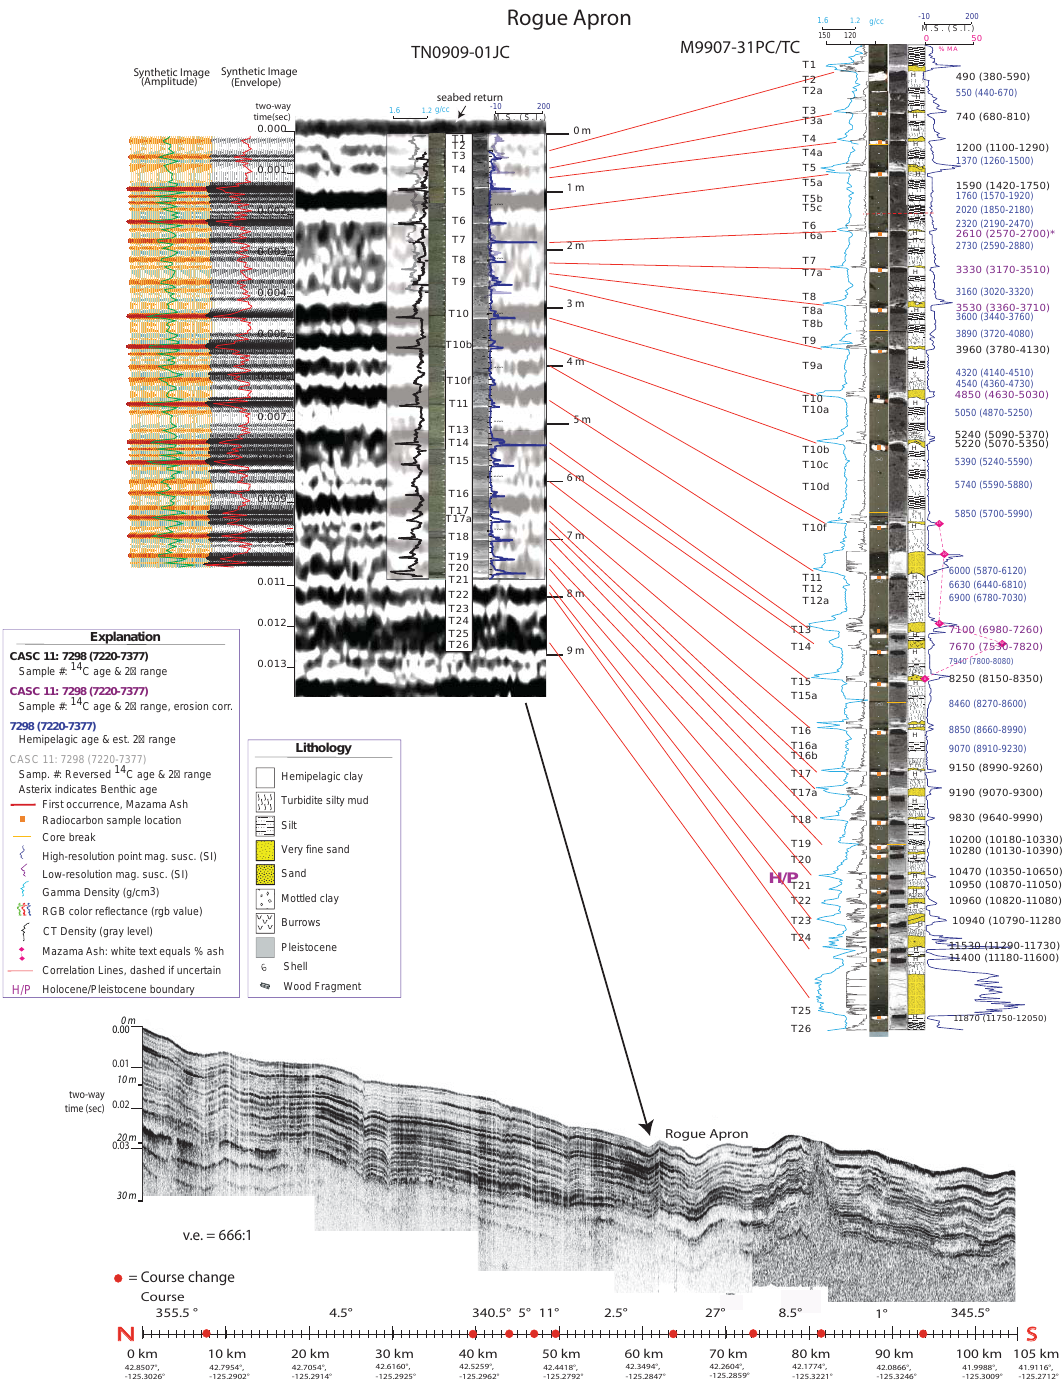
Fig. 9. Compilation of ∼ 100km of high-resolution Chirp reflection profiles parallel to the Cascadia margin. Chirp system center frequency was 4kHz, sweeping through 2–6kHz. See Fig. 1b for profile location. Correlated horizons correspond to margin-wide larger turbidites with thicker sand bases observed in Rogue Apron cores. This correlation is shown in the inset at center with core TN0909-01JC/TC and representative seismic section. Correlation ties to nearby core M9907-31PC/TC with age control shown at right. Synthetic envelope and amplitude plots from core density data from 31PC/TC shown at upper left. Margin parallel profiles image the entire Holocene section, include the late deglacial, and show the consistency of the turbidite stratigraphy and accommodation space required for sequences of thin mud turbidites along strike.